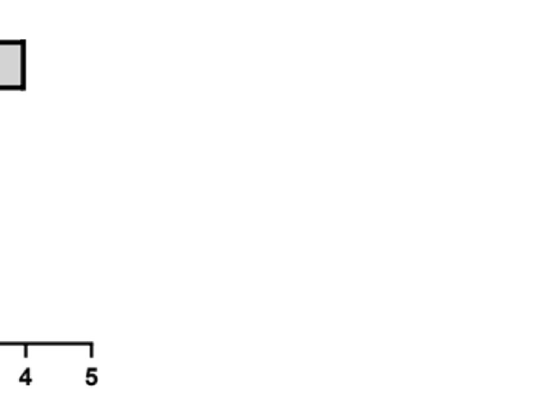
Figure 4. Events related to